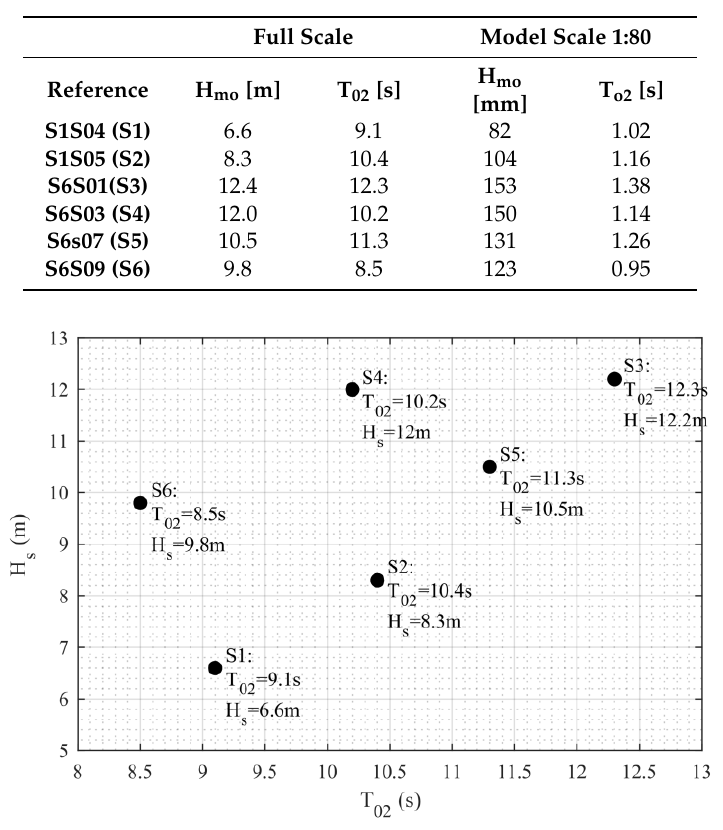
Figure 16. Plot and naming of selected sea states in full scale used in the present experimental analysis and numerical validation.